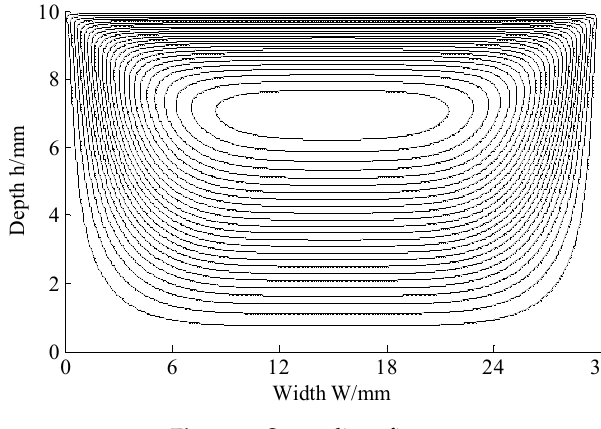
Figure 2. Streamlines figure.